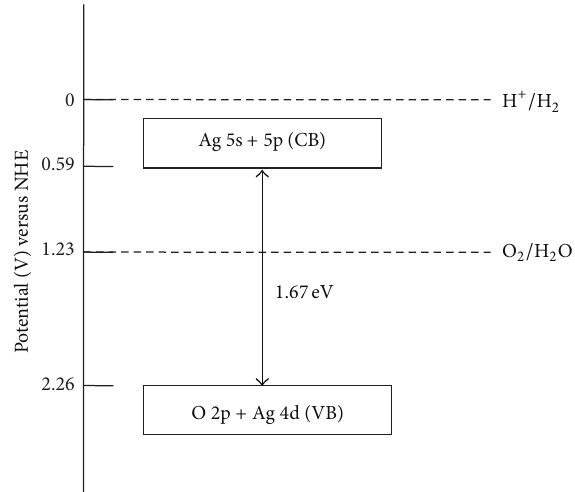
Figure 4: The calculated CBM and VBM potentials of Ag 3 AsO 4 .